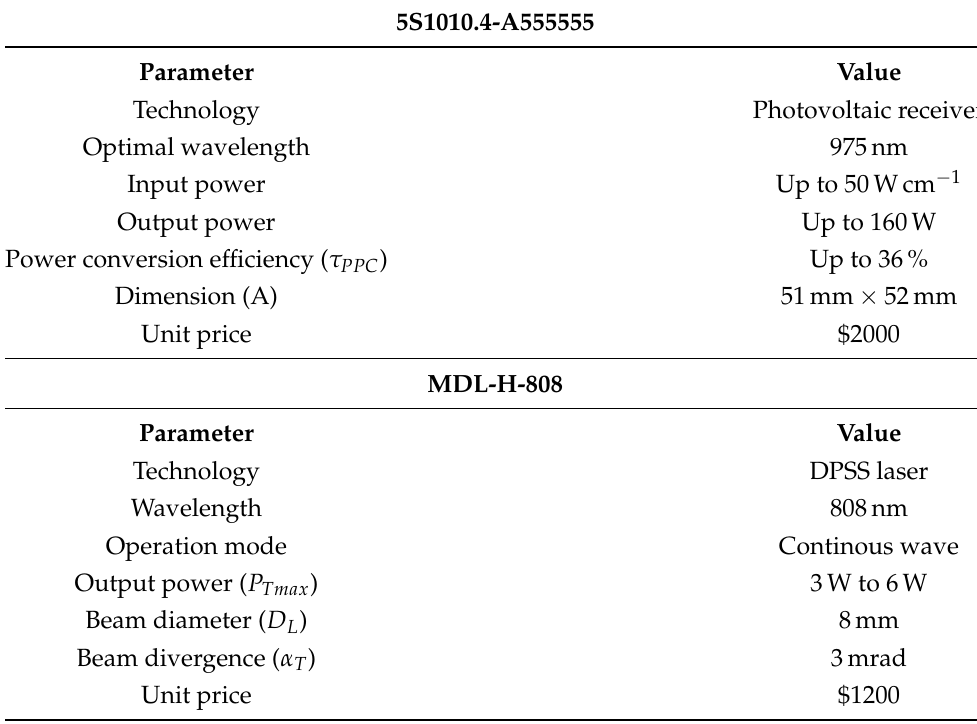
Table 2. Technical specifications of the 5S1010.4-A555555 VMJ PV cell array and MDL-H-808 laser module.